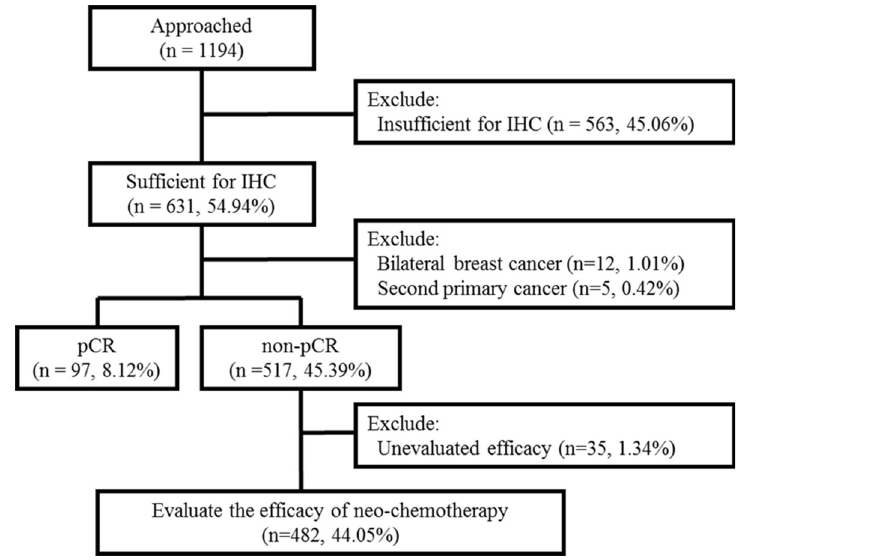
Fig 1. Flow diagram for the